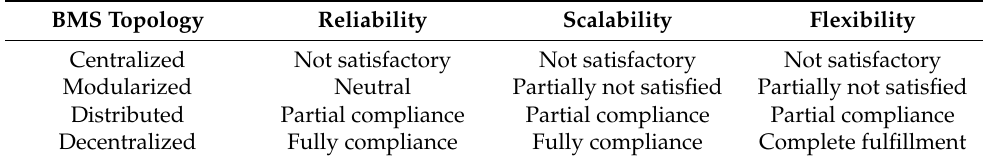
Table 3. Comparison of BMS topologies